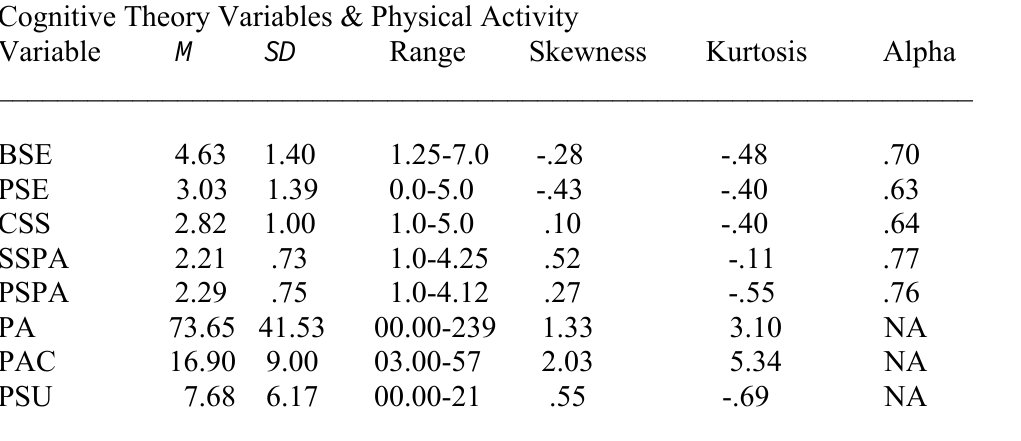
Means, Standard Deviations, Ranges, Skewness, Kurtosis, and Alpha’s for Social Cognitive Theory Variables & Physical